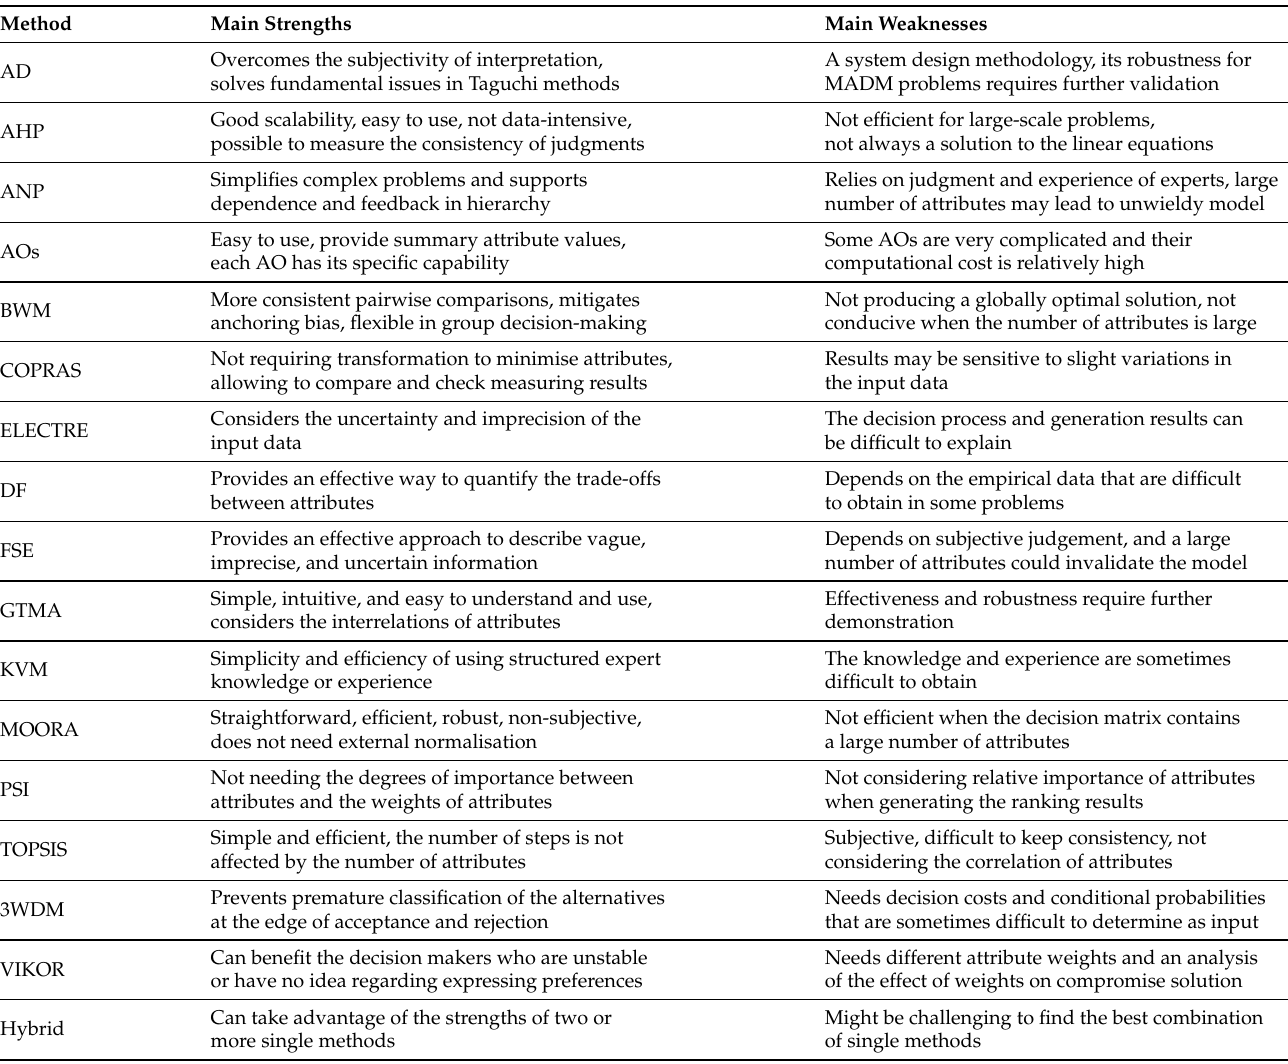
Table 2. Summary of the main strengths and weaknesses of the MADM methods applied in